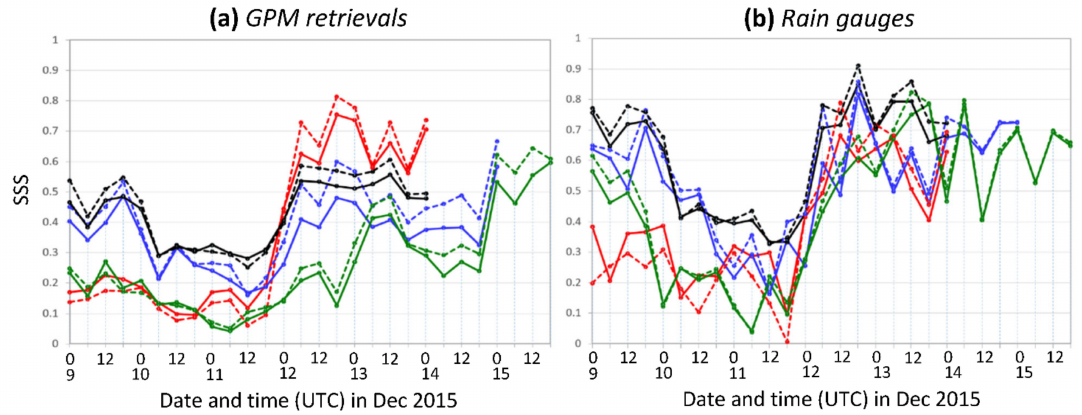
Figure 18. As in Figure 13, except for SSS of 24 h QPFs for 14 (red), 15 (blue), and 16 December (green) and 72 h QPFs for 14–16 December (all times in UTC) during TY Melor (2015), computed over the big (solid) and small (dashed) domains using ( a ) GPM rainfall retrievals and ( b ) rain gauge observations. The two domains are shown in Figure